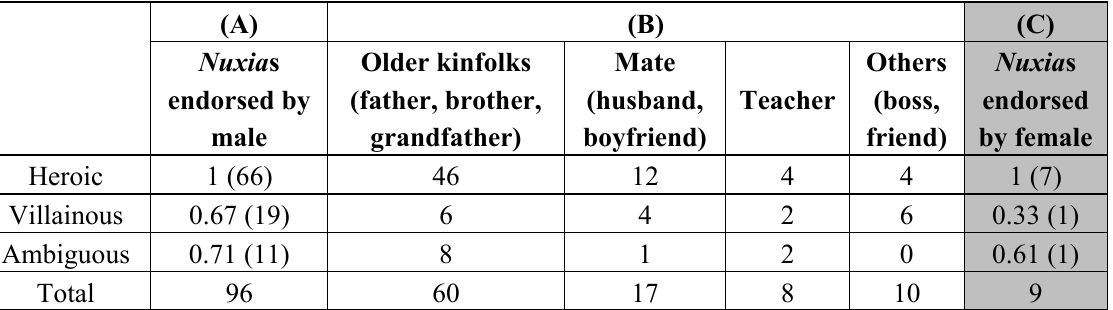
Table 5. ( A ) The normalized index indicating the nuxia characters’ male endorsement; ( B ) details of the endorsers; and ( C ) female